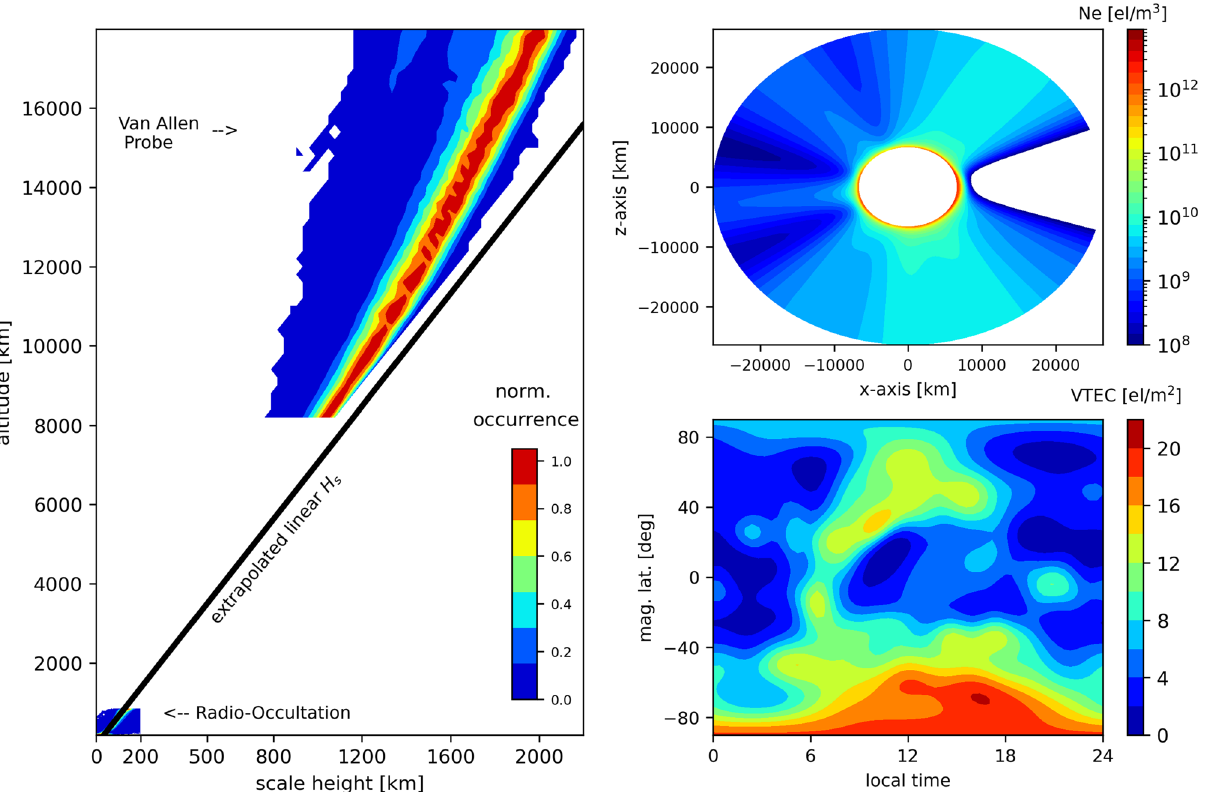
Figure 2. Left panel: 2D histogram of the normalized occurrence of the electron density distributions obtained by RO and Van Allen Probe. It shows the superposition of the graphs of Fig. 1, where the black line shows the H s linear extrapolation using RO measurements. Top right: Meridional cross-sections corresponding to the longitudinal section. One side is 0 and the opposite side is 180 E at zero hours in Universal Time (UT). The electron density profiles are linearly extrapolated with the RO measurements. Bottom right: VTEC representation from 800 km up to 20,000 km when the scale height is linearly extrapolated with the RO measurements. The RO data was obtained using averaged values from the first 60 days of 2014 using the harmonic fitting of Prol et al. 18 in terms of local time and magnetic